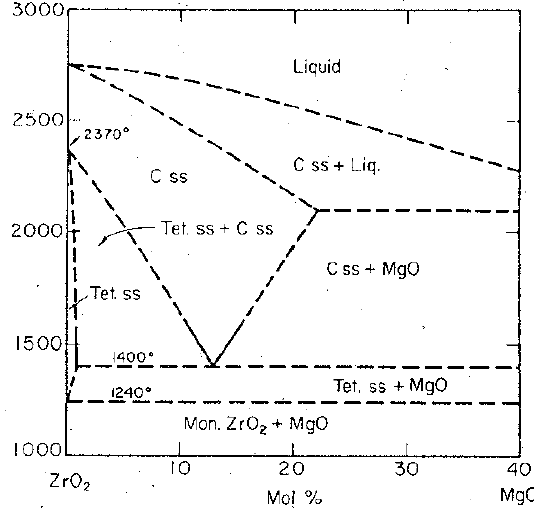
Figure 6. Phase diagram of the system ZrO 2 -MgO.